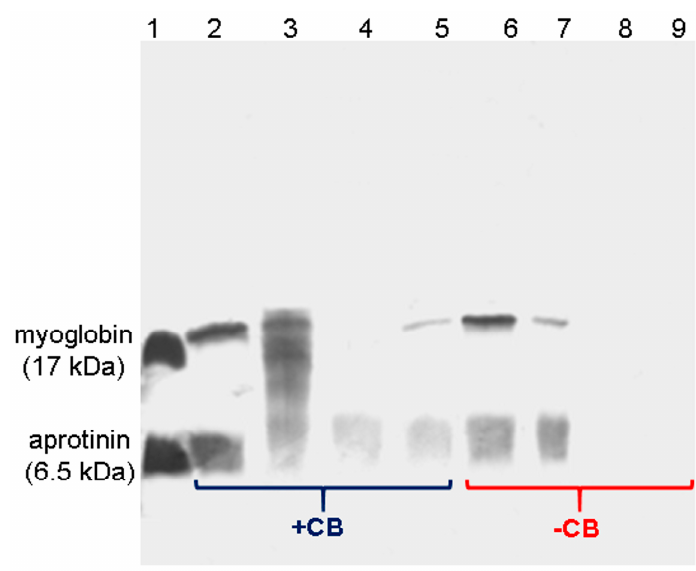
Figure 5. SDS-PAGE analysis of model proteins captured by FCSNP with (+CB) and without ( − CB) Cibacron Blue. Model proteins, myoglobin, 17 kDa, and aprotinin, 6.5 kDa (lane 1); wash with PB (lanes 2 and 6); elution with 50% isopropanol (3 and 7); elution with 50% methanol (lanes 4 and 8), elution with ACN + NH 4 OH (lanes 5 and 9). Model proteins were obtained only in the elutions with 50% methanol and ACN + NH 4 OH with the +CB nanoparticles, and were absent from similar elutions with the − CB nanoparticles.